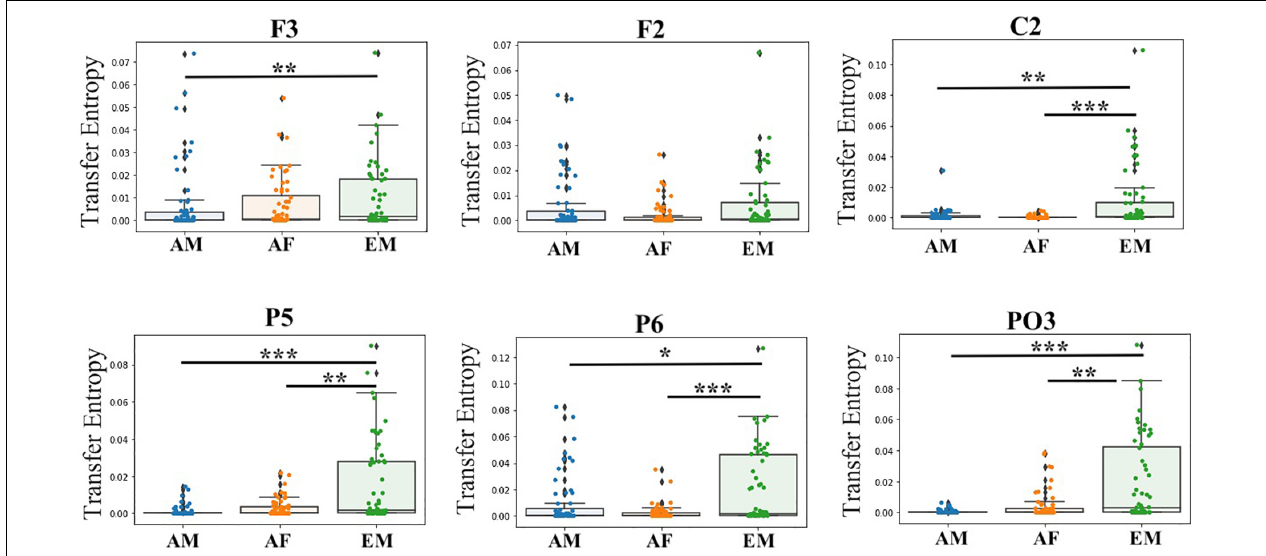
FIGURE 7 | Paired Wilcoxon rank sum test between common channels (i.e., F3, F2, C2, P5, P6, and PO3) in AF, AM, and EM settings. Asterisks mark significant differences in the channels between settings (* p < 0.05; ** p < 0.01; *** p < 0.001).